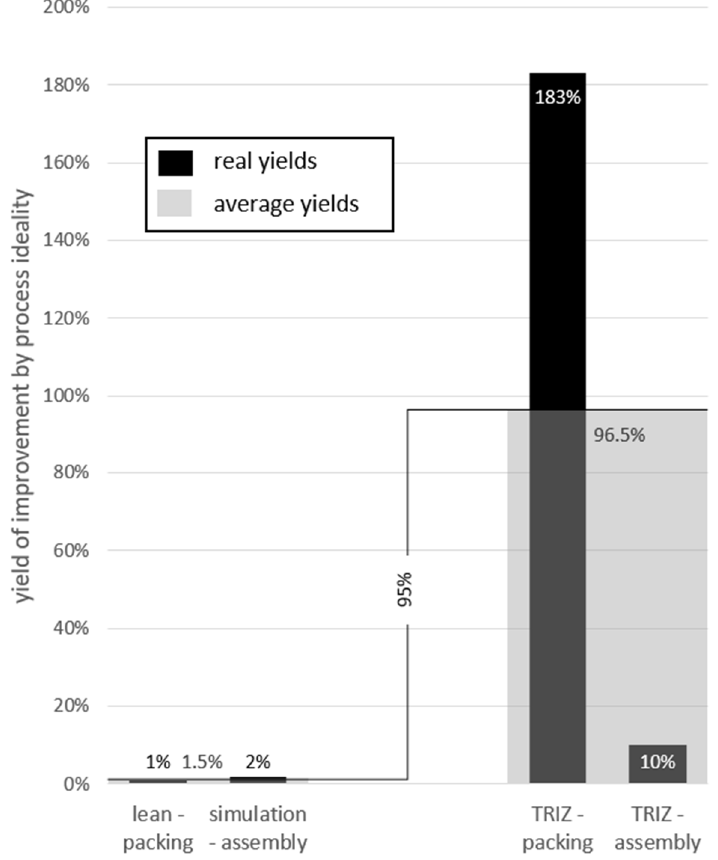
Figure 12. Yields of improvement due to the process ideality.